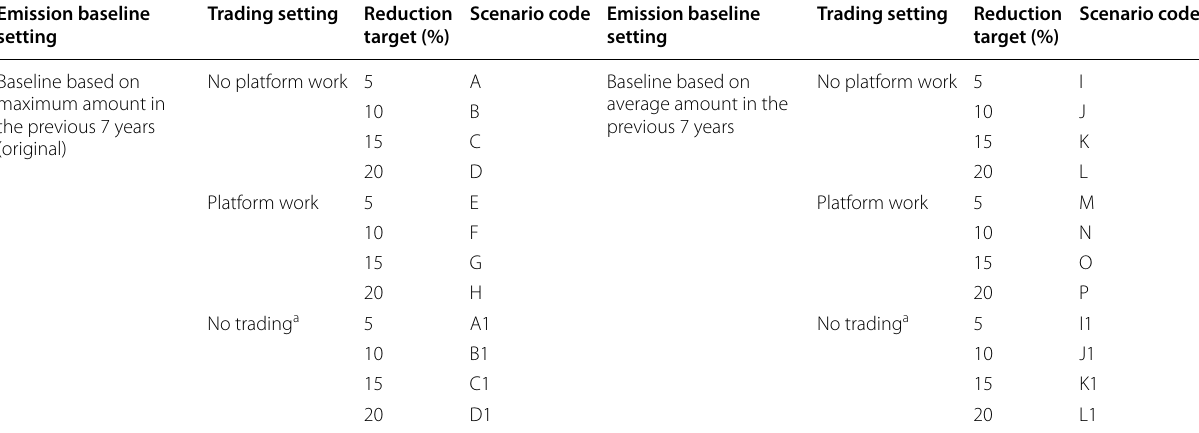
a No trading means that polluters do not offset the s by trading and reduce emissions under the target setting